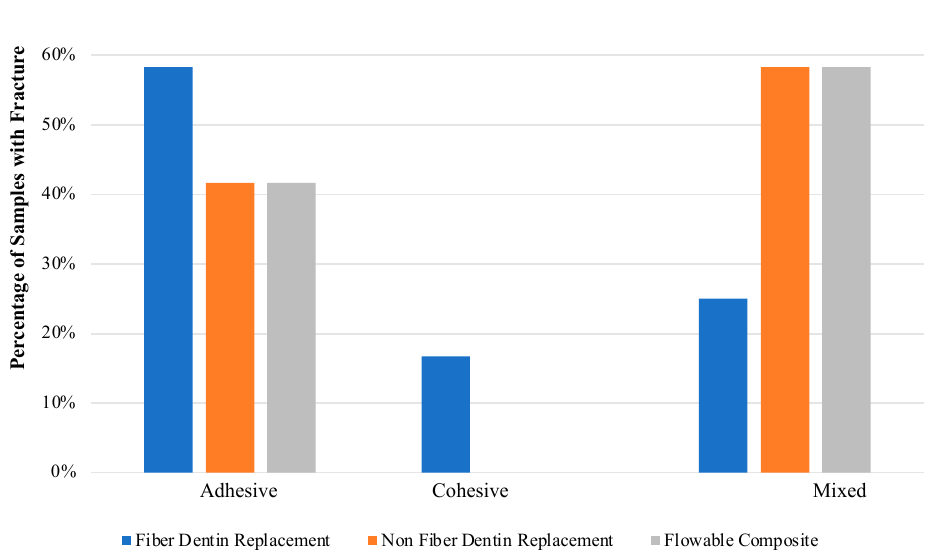
Figure 6. Quantitative fracture pattern on fiber dentin replacement, non-fiber replacement and flowable composite group.